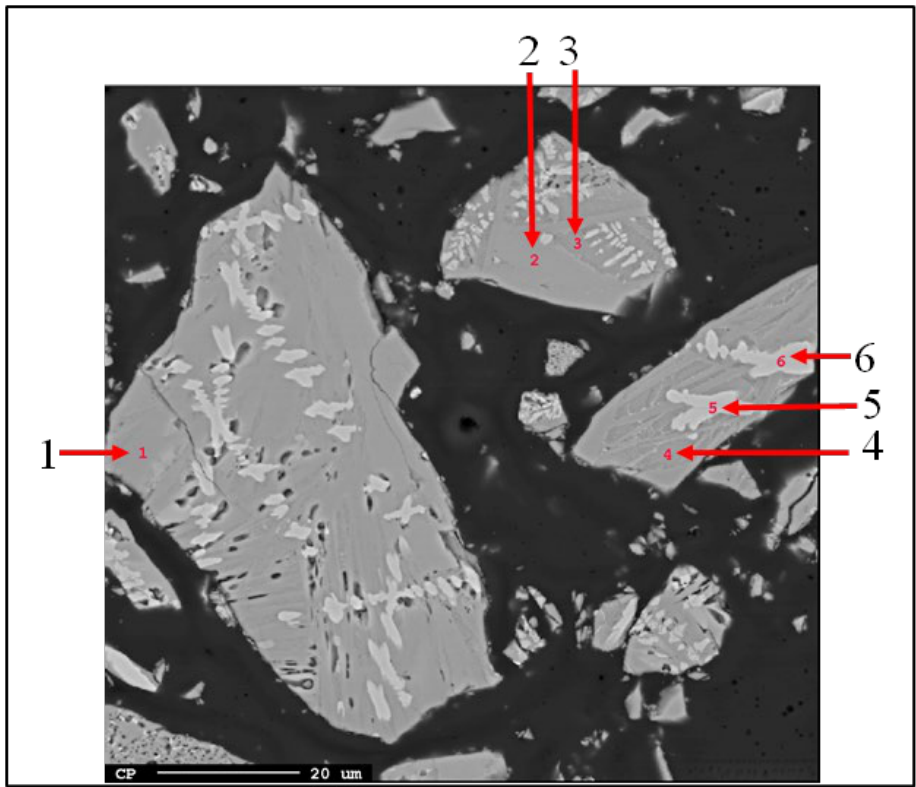
Figure 4. EPMA micrograph and the analyzed points for characterization. Points 1 and 2 (mayenite), points 3 and 4 (gehlenite), points 5 and 6 (perovskite).